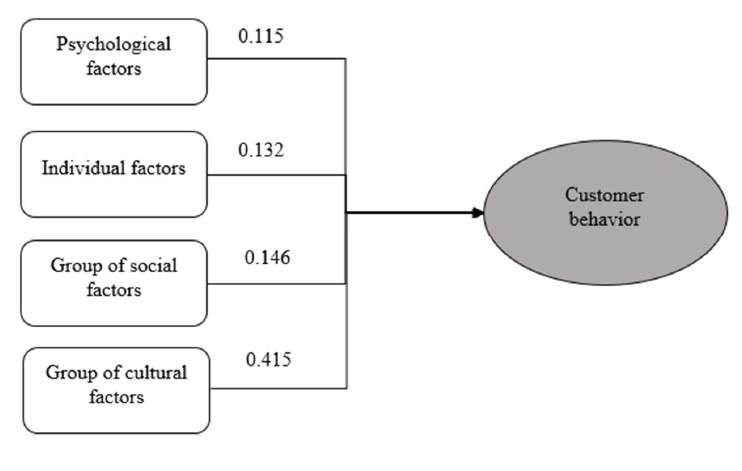
Fig. 2. Research Hypotheses Testing